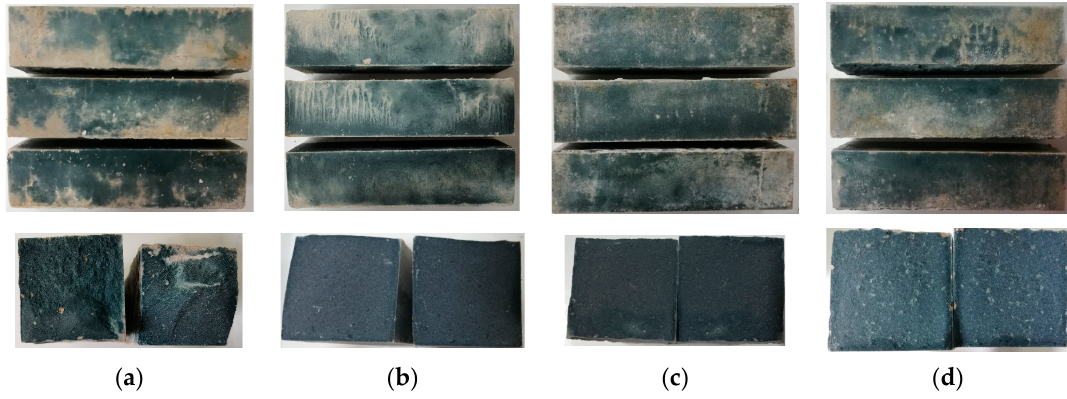
Figure 2. SSG geopolymer and cross section. ( a ) SSG1, ( b ) SSG5, ( c ) SSG9, ( d ) SSG13.